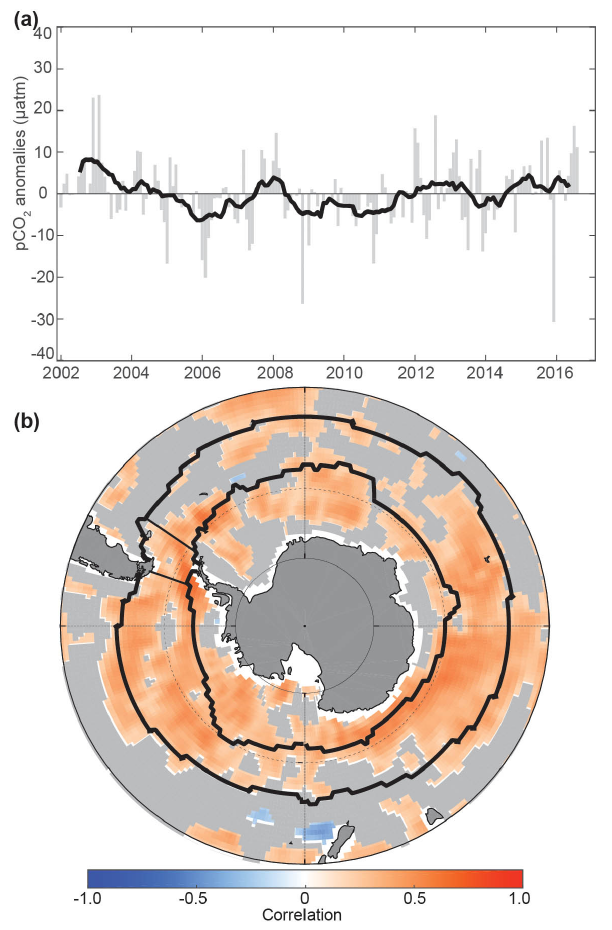
Figure 4. (a) Temporal evolution of deseasonalized, detrended monthly SOCAT-DP p CO 2 anomalies (gray bars) over 2002–2016, with 12-month running averages (black line) overlain. (b) Correla- tion between monthly SOCAT-DP p CO 2 anomalies and the p CO 2 anomalies estimated from the SOM-FFN-noDP product (created without the inclusion of Drake Passage data), for years 2002–2016 at each 1 ◦ × 1 ◦ grid cell. Gray shading represents areas where the correlation does not pass significance t -tests at p< 0 . 05.